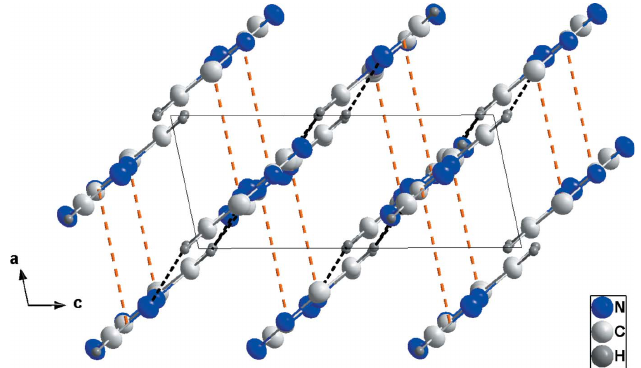
Figure 3 Packing seen along the b -axis direction giving a side view of the layers. Hydrogen bonds are depicted as in Fig. 2 and the (cid:2) -stacking interactions are shown as orange dashed lines.